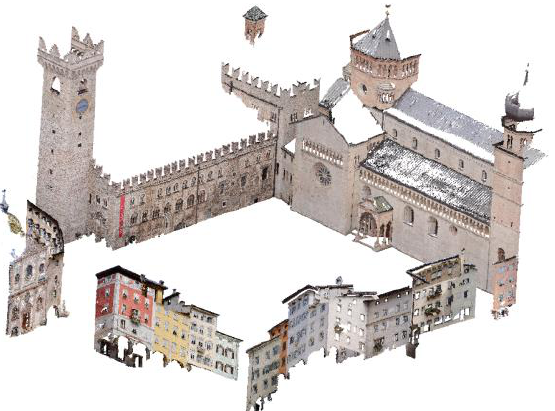
Figure 4. Photogrammetric dense reconstruction of the Duomo square in Trento (Italy).